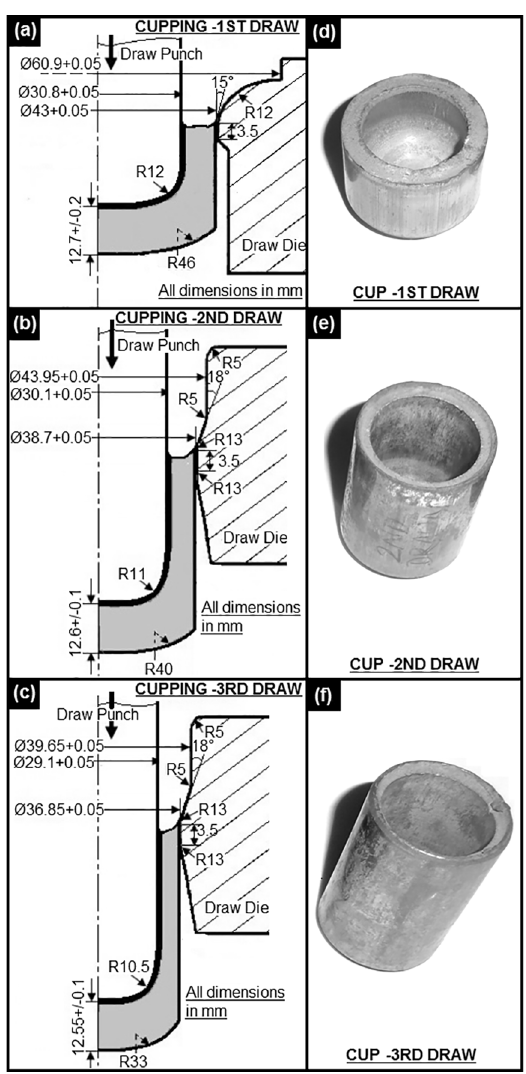
Figure 3. 3-stage cup drawing, (a-c) schematically showing of arrangements; (d-f) photo images of drawn cups.